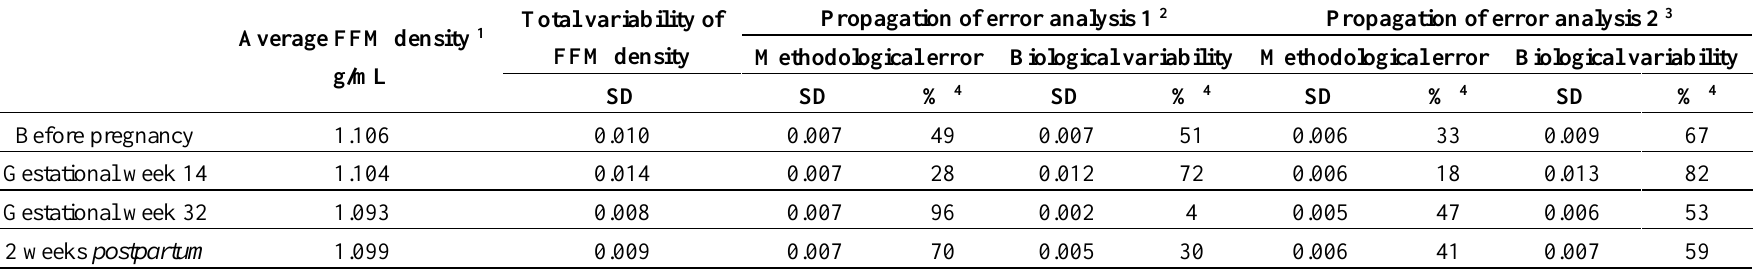
Table 2. Average and total variability of FFM density in women before, during and after pregnancy. The contributions to total variability of methodological error and biological variability using two sets of assumptions are also